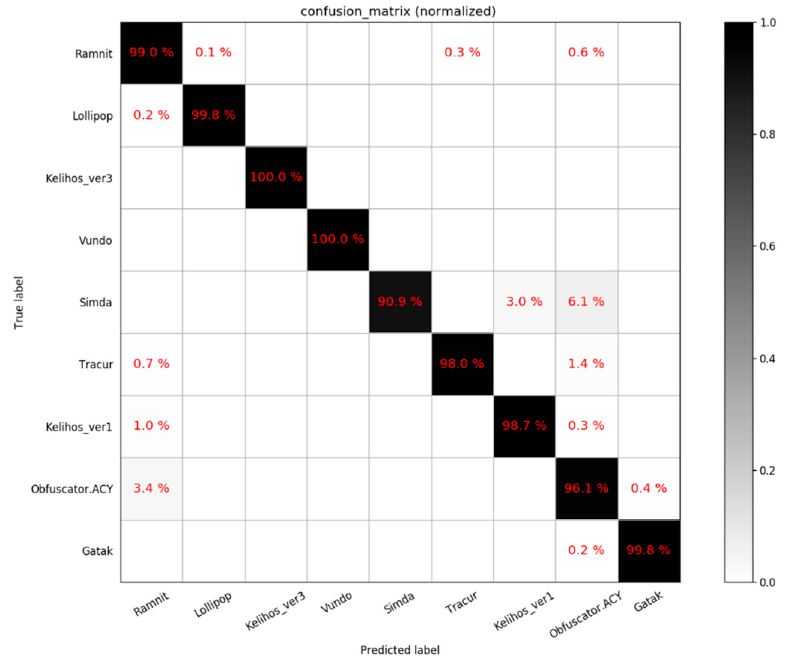
Figure 6. The normalized confusion matrix of the classification result (1).